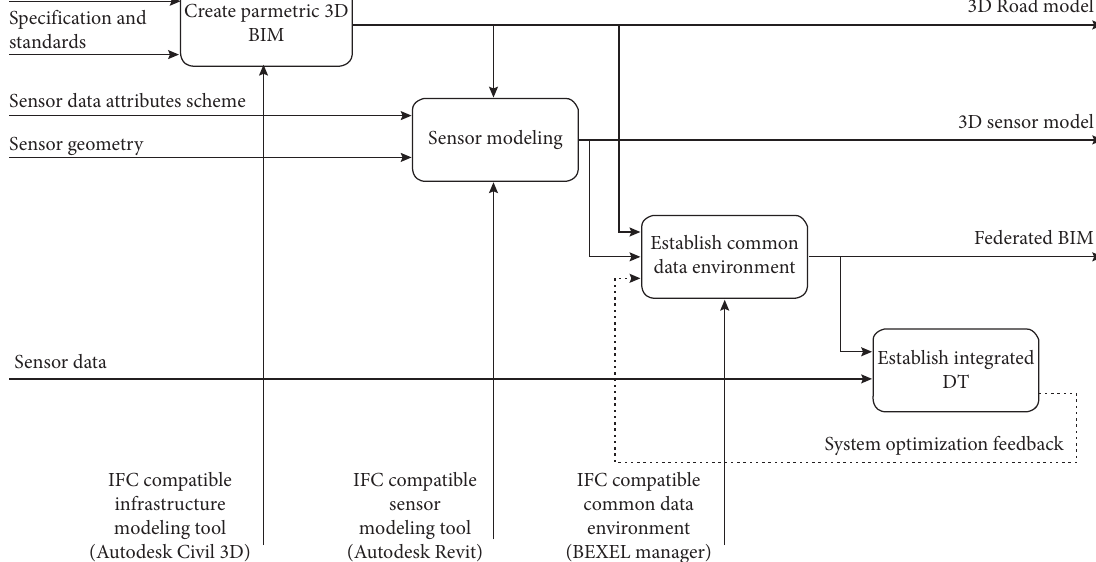
Figure 5: IDEF0 case study execution workflow